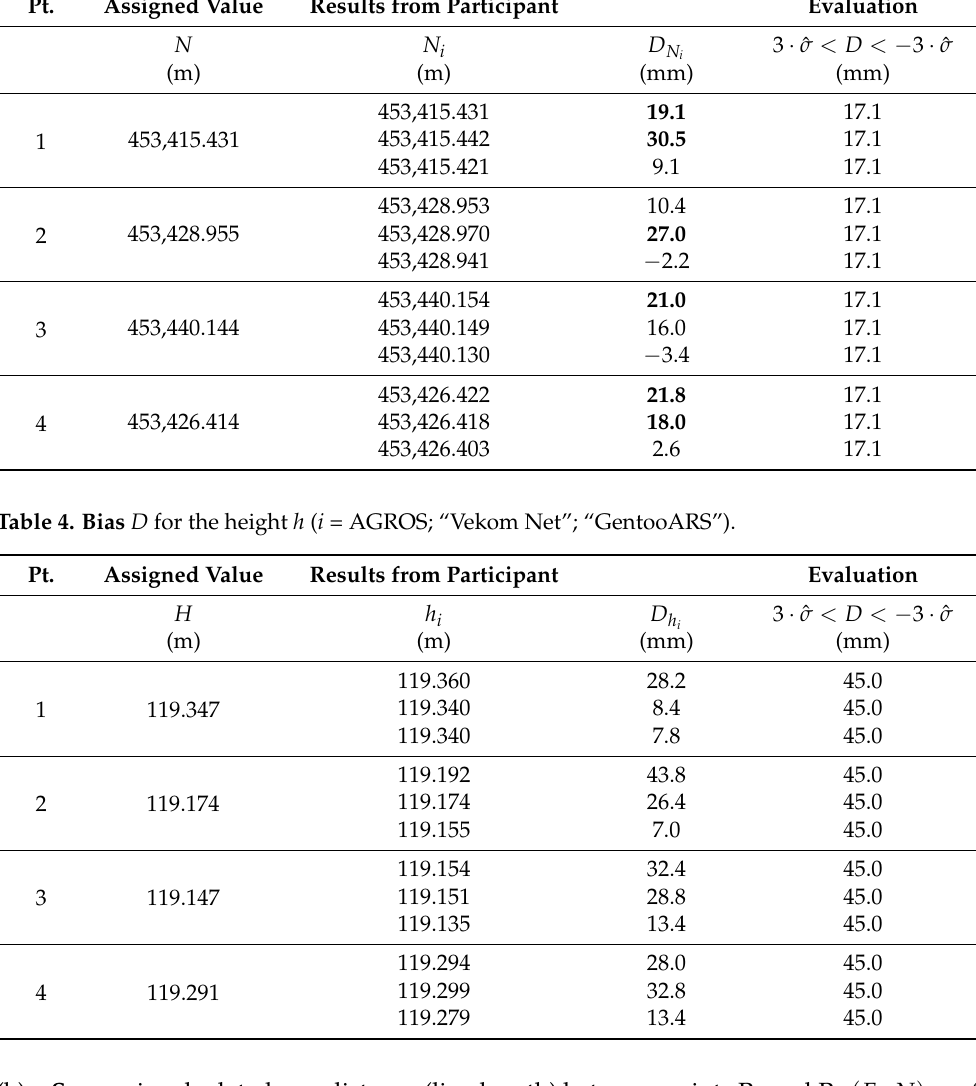
Table 3. Bias D for the coordinate N ( i = AGROS; “Vekom Net”; “GentooARS”). Pt. Assigned Value Results from Participant Evaluation